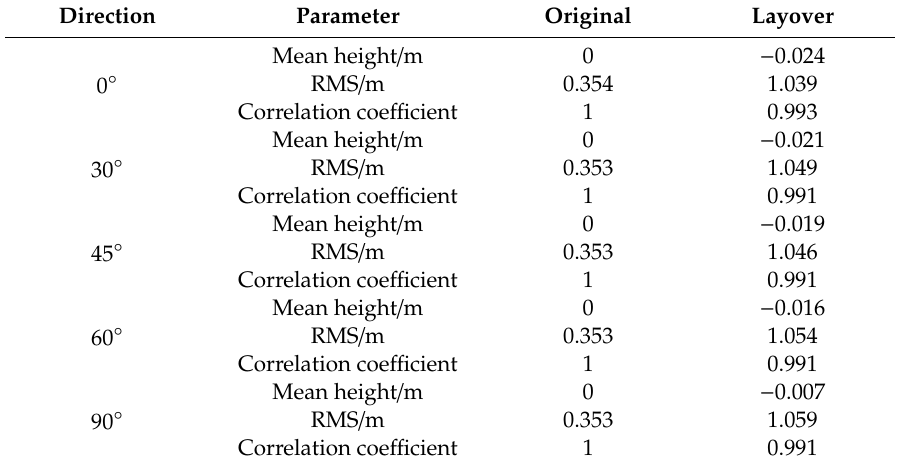
Figure 6. Simulation results of original sea surface ( a ) and added layover sea surface (in m). The swell propagation direction is 0° ( b ), 45° ( c ), and 90° ( d ) to the range direction. Table 5. The influence of layover under di ff erent swell propagation directions (the SWH is 2 m, the wavelength is 200